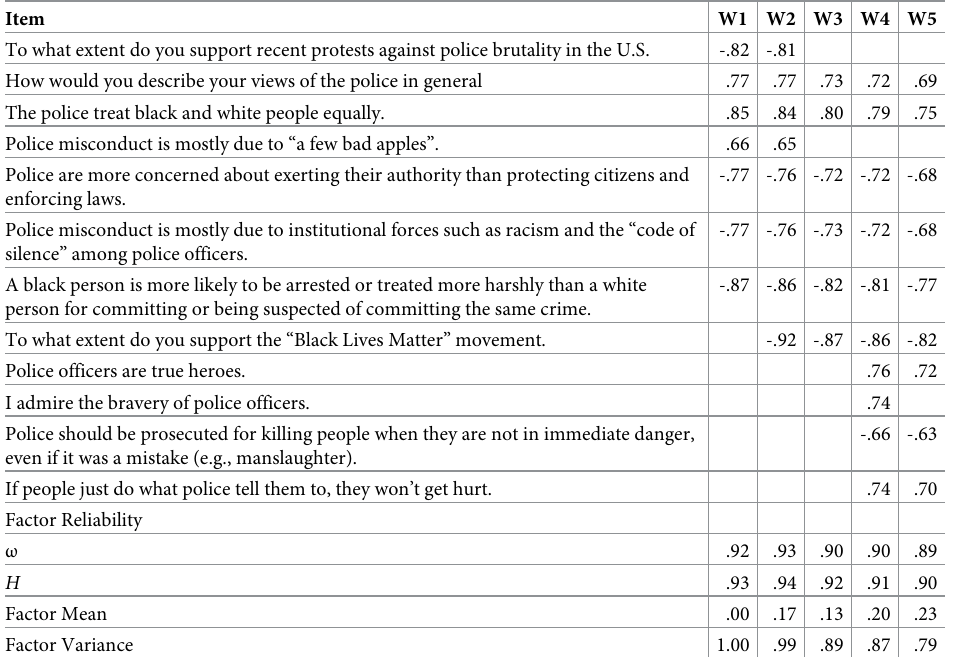
Table 2. Items assessing attitudes about police and standardized factor loadings for each